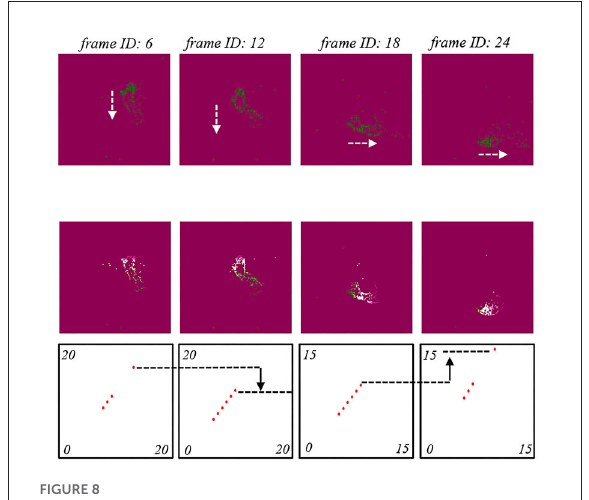
FIGURE8 The temporal SNN with the performances of feature index E performances. The origin frames of a counter-clockwise counter event. The temporal SNN outputs and spiking patterns. The temporal SNN with feature index H. The temporal SNN with feature index J. The arrow indicates moving trajectory of the generated spikes.